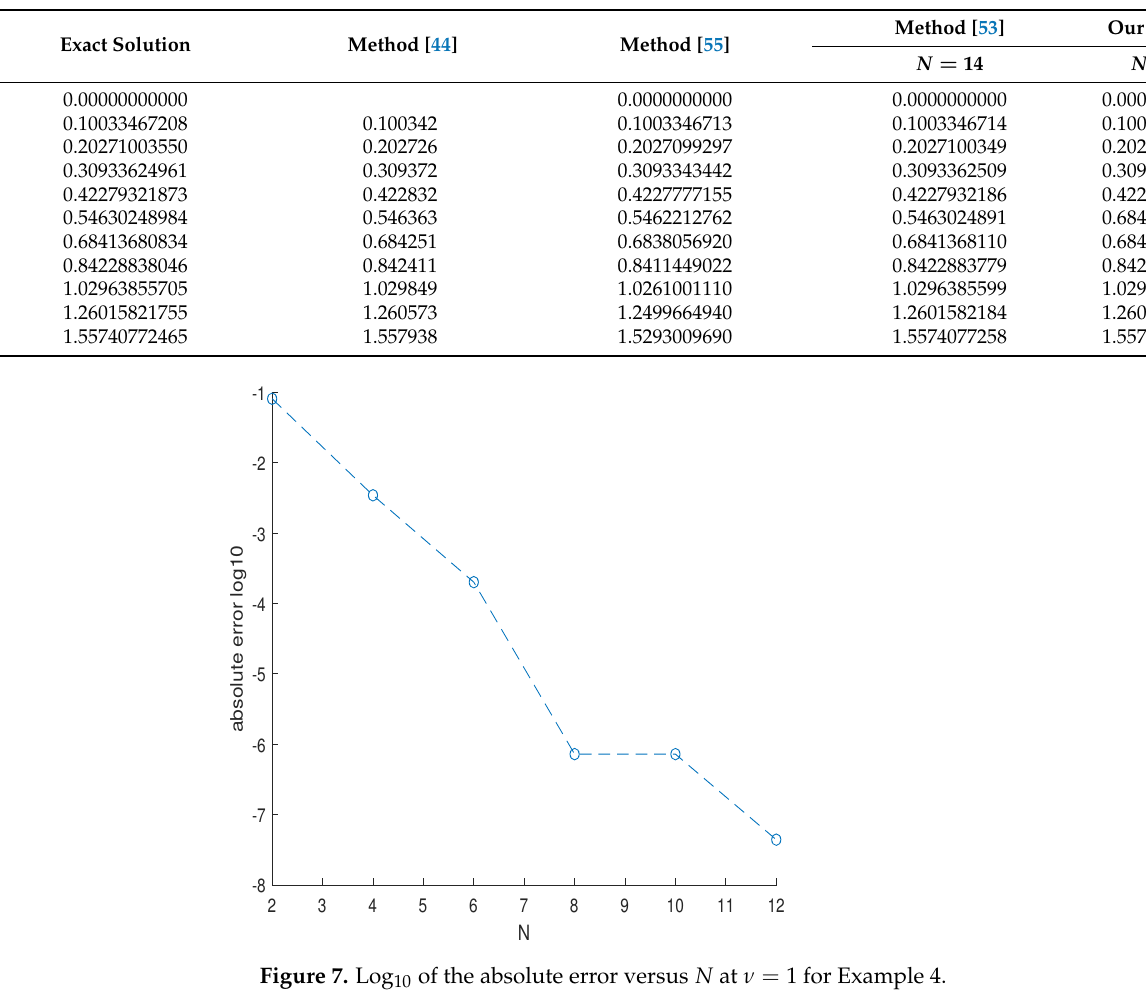
Table 4. Comparison of the approximate solution of Example 4, using the MLG method, to the solutions obtained by the methods presented in [44,53,55] for ν = 1: